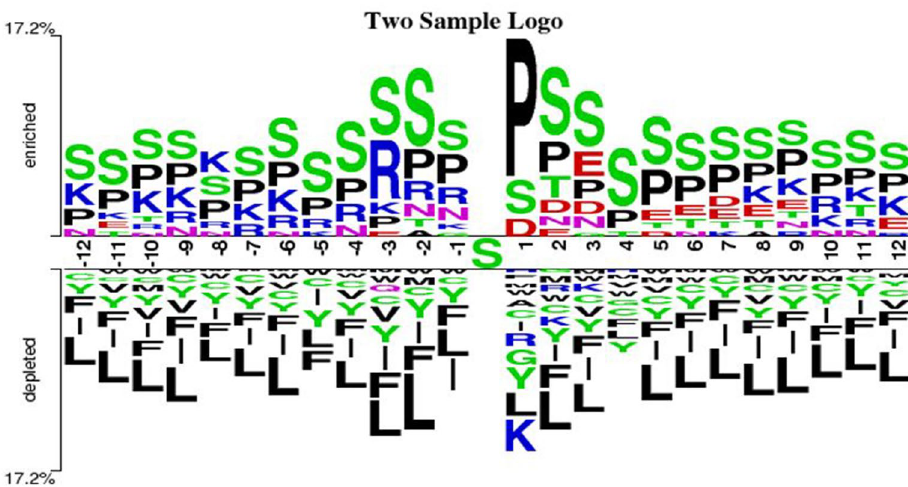
Figure 2. Two study logos program 58 presents the occurrences of amino acid propensities of surrounding positive windows (phosphorylation site) and negative windows (non-phosphorylation sites) of size